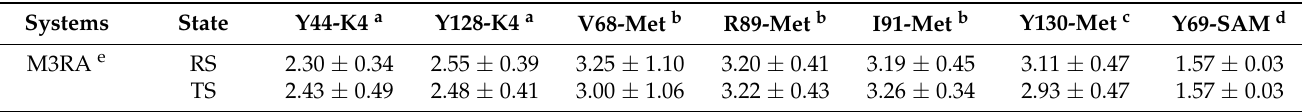
Table 2. Mean values for some selected interaction distances between the cofactor and substrate at the catalytic site, for M3RA, and the mutants Y44F, Y128F, Y44A, Y128A, Y69F, and Y130F for their respective RS and TS for the mono-methyl-transfer reaction. Distances are in Å and are provided with their corresponding standard